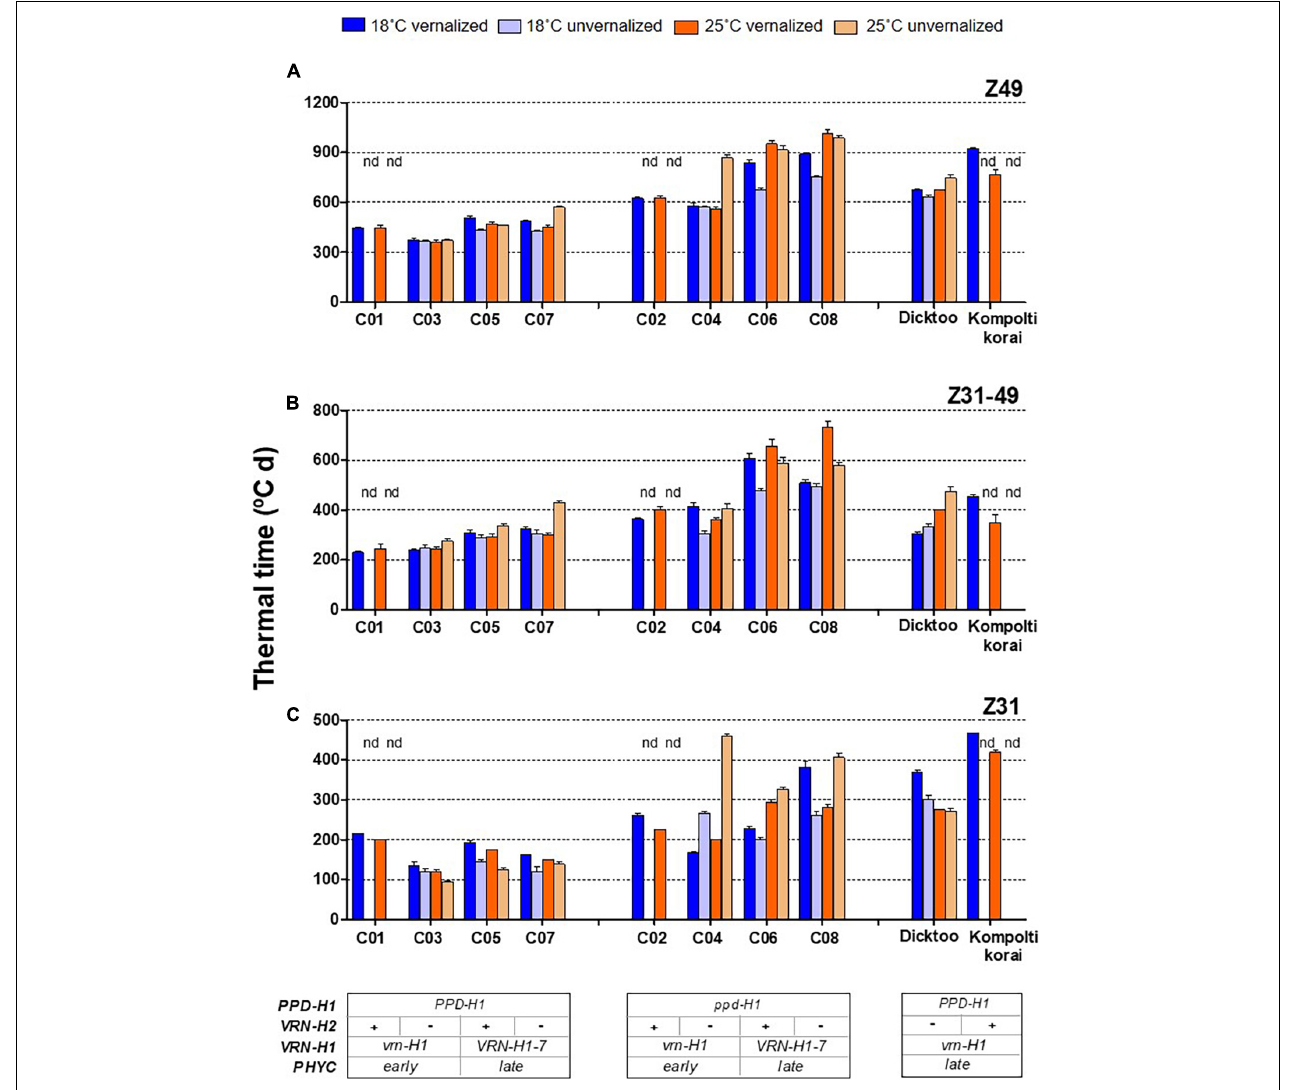
FIGURE 1 | Plant growth duration from the onset of the experiment until flowering (A) from onset of stem elongation until flowering time (B) and from the onset of experiment until the appearance of the first node (C) for different barley NILs, whose genetic background is indicated at the bottom of the figure (inset tables). The four treatments, combinations of vernalization or absence of vernalization and temperature (18 ◦ C or 25 ◦ C) are color coded. Lines C01, C03, C05 and C07 carry dominant PPD-H1 alleles, whilst C02, C04, C06 and C08 carry a recessive ppd-H1 . “nd” means not-determined. Dicktoo and Kompolti korai are check cultivars. Bars represent mean ± standard error of the mean